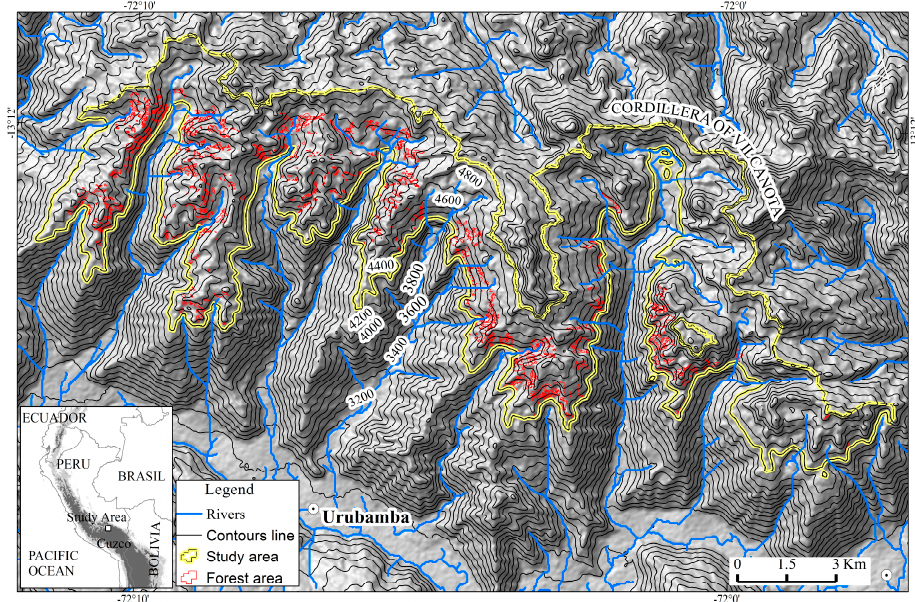
Figure 1. Map of the study area (yellow outline) between 4300 and 4800 m a.s.l. on the southern flanks of the Cordillera Urubamba, Cusco. The location of Polylepis subsericans forest stands is shown by red outlines. Rivers are shown by blue lines.